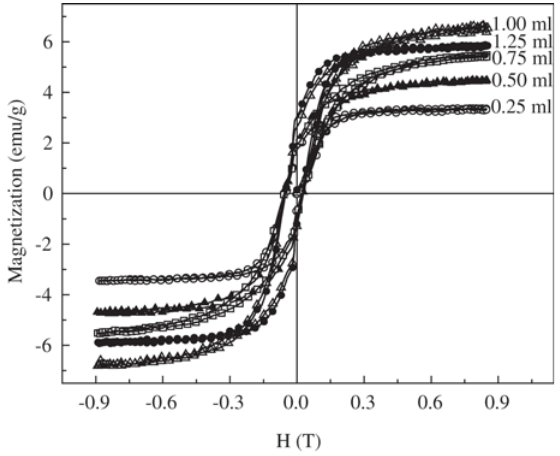
Figure 3. Room temperature hysteresis curves of the Fe granular alloy samples in different nitric acid concentrations.